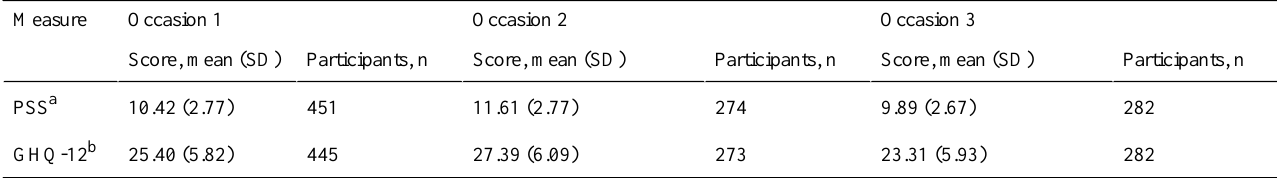
Table 4. Perceived stress and mental distress levels for the 3 occasions.